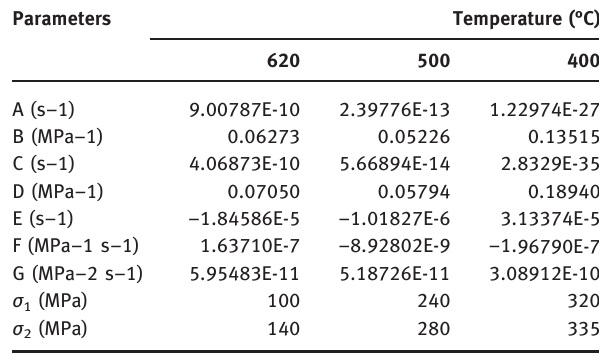
Table 3: Material constants in creep constitutive equations.